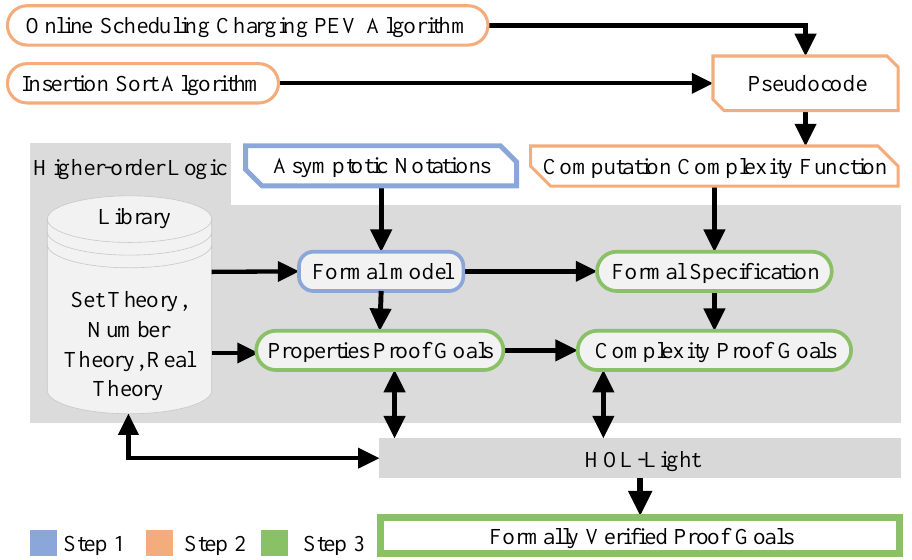
Figure 3. Proposed methodology for PEV charging algorithms in